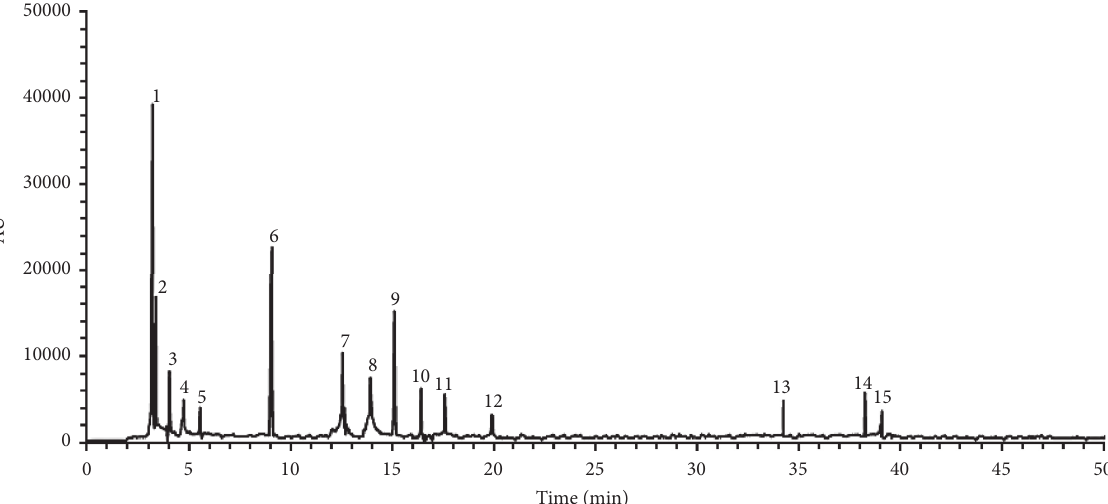
Figure 3: HPLC diagram of phenolic compounds of aqueous